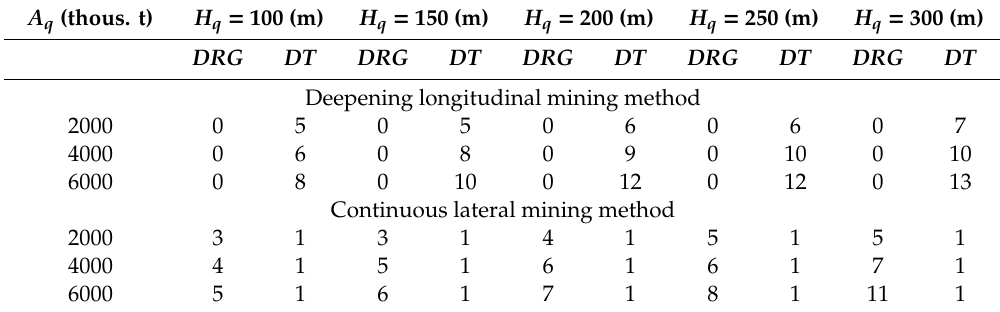
Table 3. The number of draglines ( DRG ) and dump trucks ( DT ) used for overburden transporting, in accordance with selected mining method, pit depth ( H q ) and annual capacity ( A q , thousand tons). A q (thous. t)